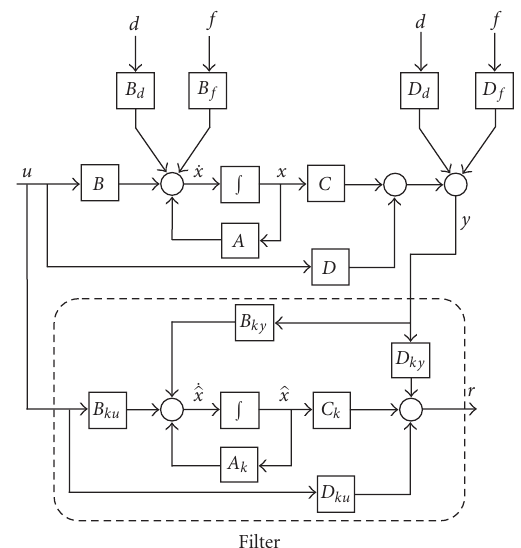
Figure 1: Filter-based robust FDI